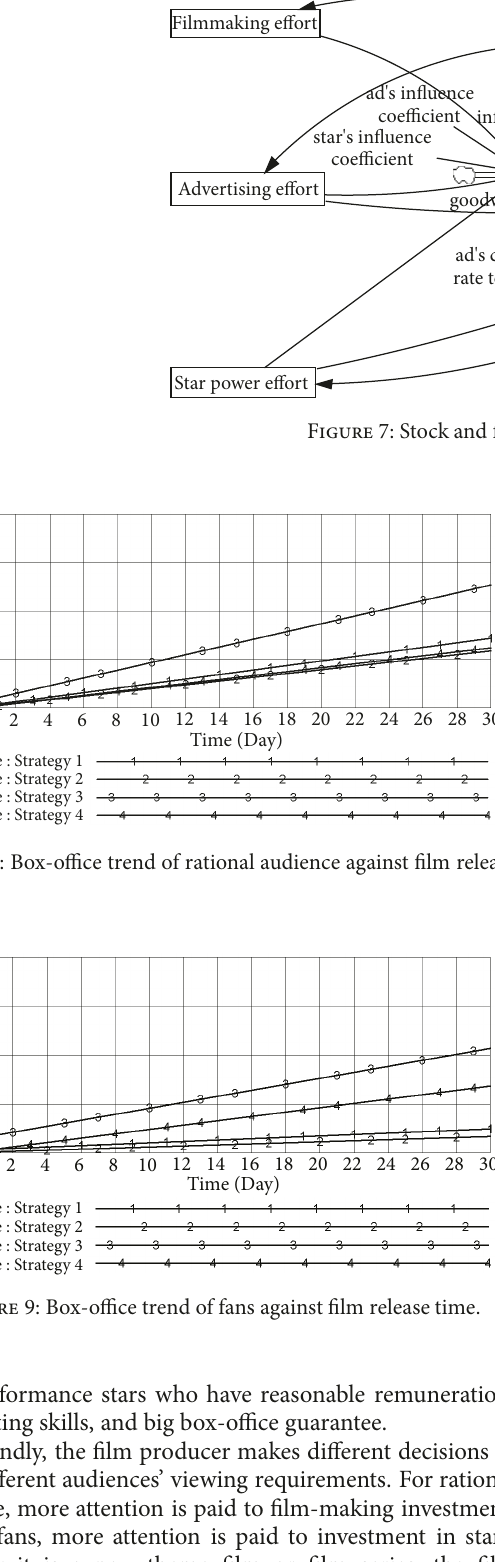
cost-performance stars who have reasonable